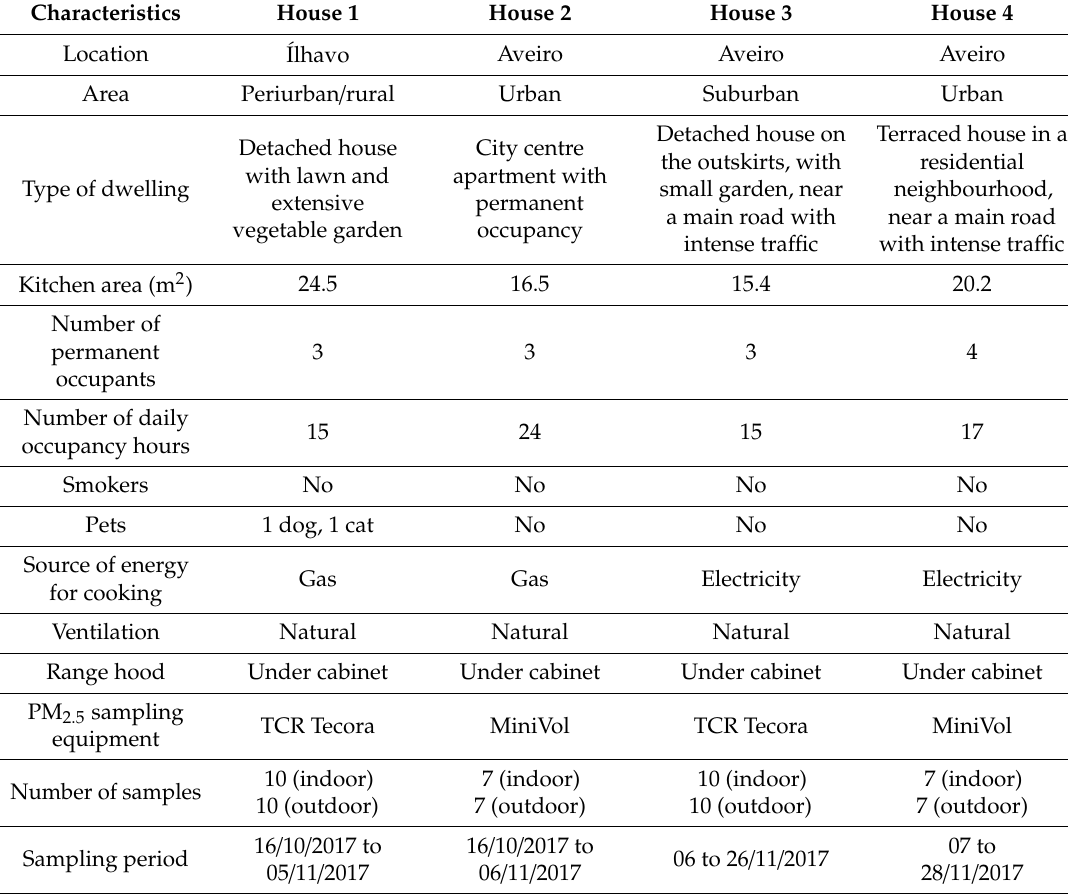
Table 1. Characterisation of dwellings and sampling